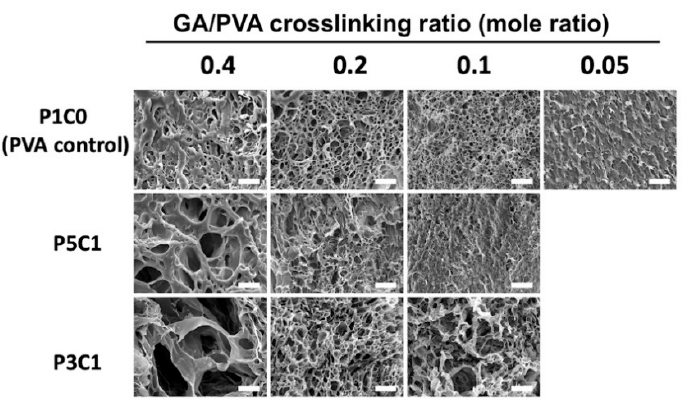
Figure 4. SEM images of PVA/CMC scaffolds. Hydrogels were crosslinked by GA at different mole ratios of GA/PVA and freeze-dried. PVA without CMC (P1C0) served as a control group. Scale bar = 50 µ m. P1C0 is PVA/CMC = 1:0; P5C1 is PVA/CMC = 5:1; P3C1 is PVA/CMC = 3:1.